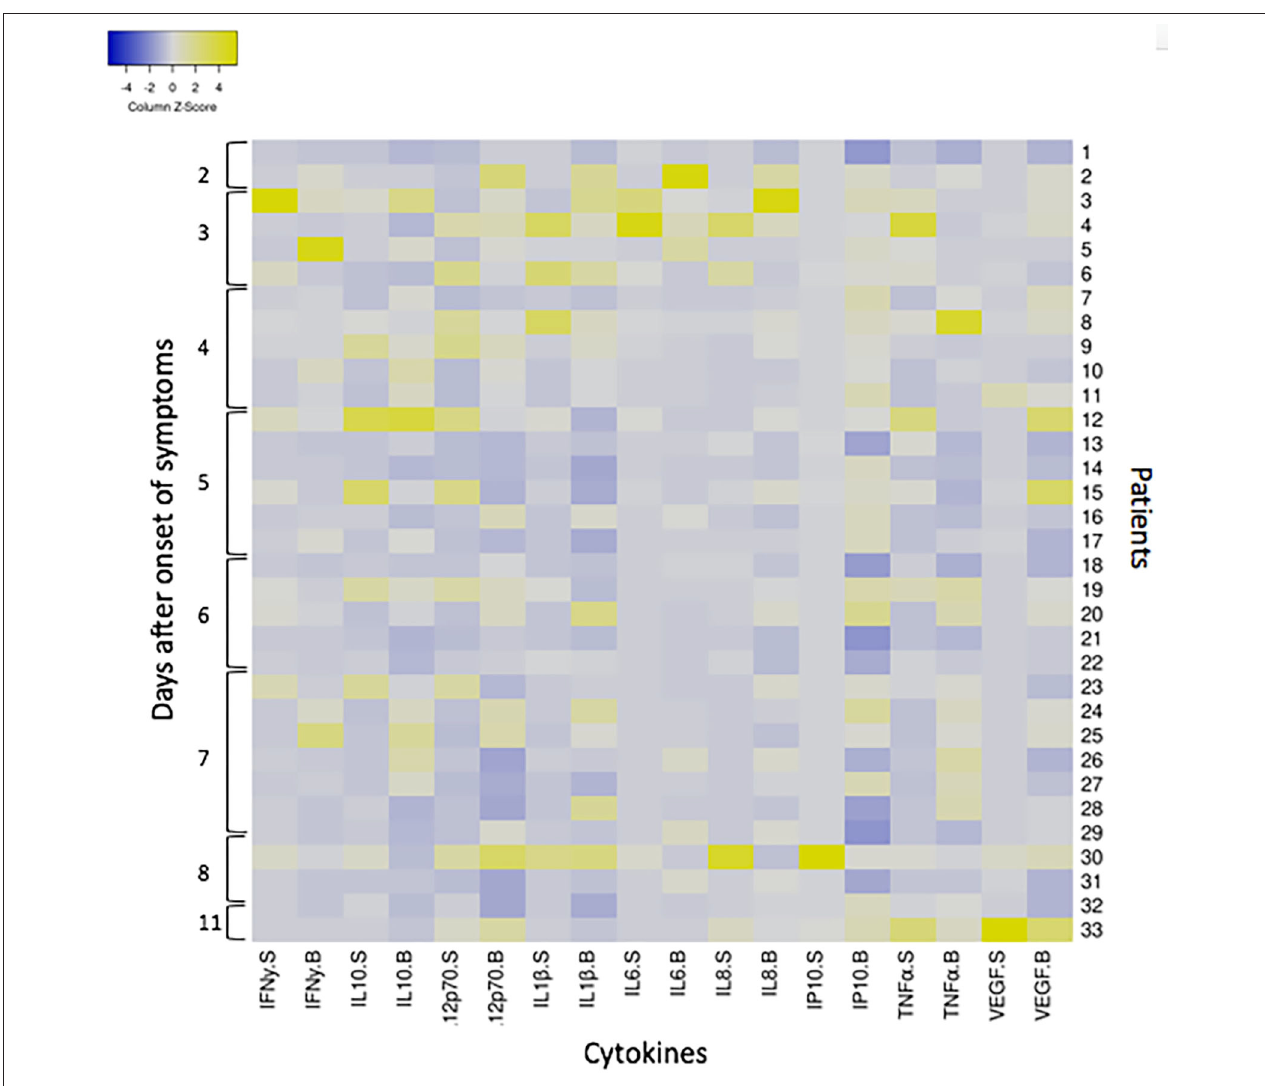
FIGURE 3 | Heatmap showing the cytokine response to ANDV infection in 33 ANDV-infected cases in saliva and serum samples concomitantly taken. The heatmap was constructed in Heatmapper (www.heatmapper.ca; Babicki et al., 2016) according to the fold increase of each cytokine (INF γ , IL10, IL12p70, IL1 β , IL6, IL8, IP10, TNF α , and VEGF) concentration of 33 ANDV-infected patients normalized against the median concentration of healthy subjects. Columns represent the Z-scored data for each patient split into two compartments, saliva (S) and serum (B). Rows represents each individual (from 1 to 33) according to days since the onset of symptoms. Colors indicate deviations from the mean of zero (white), as indicated in the color key (Z-score − 4 blue, and 4